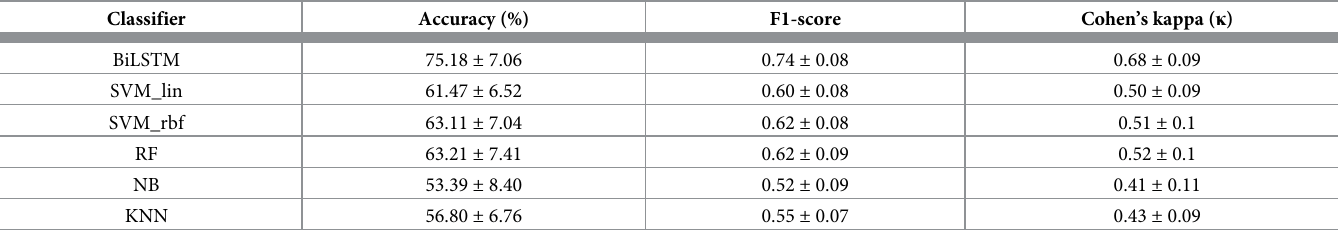
Table 1. Overall performance of the BiLSTM network and other conventional machine learning methods.